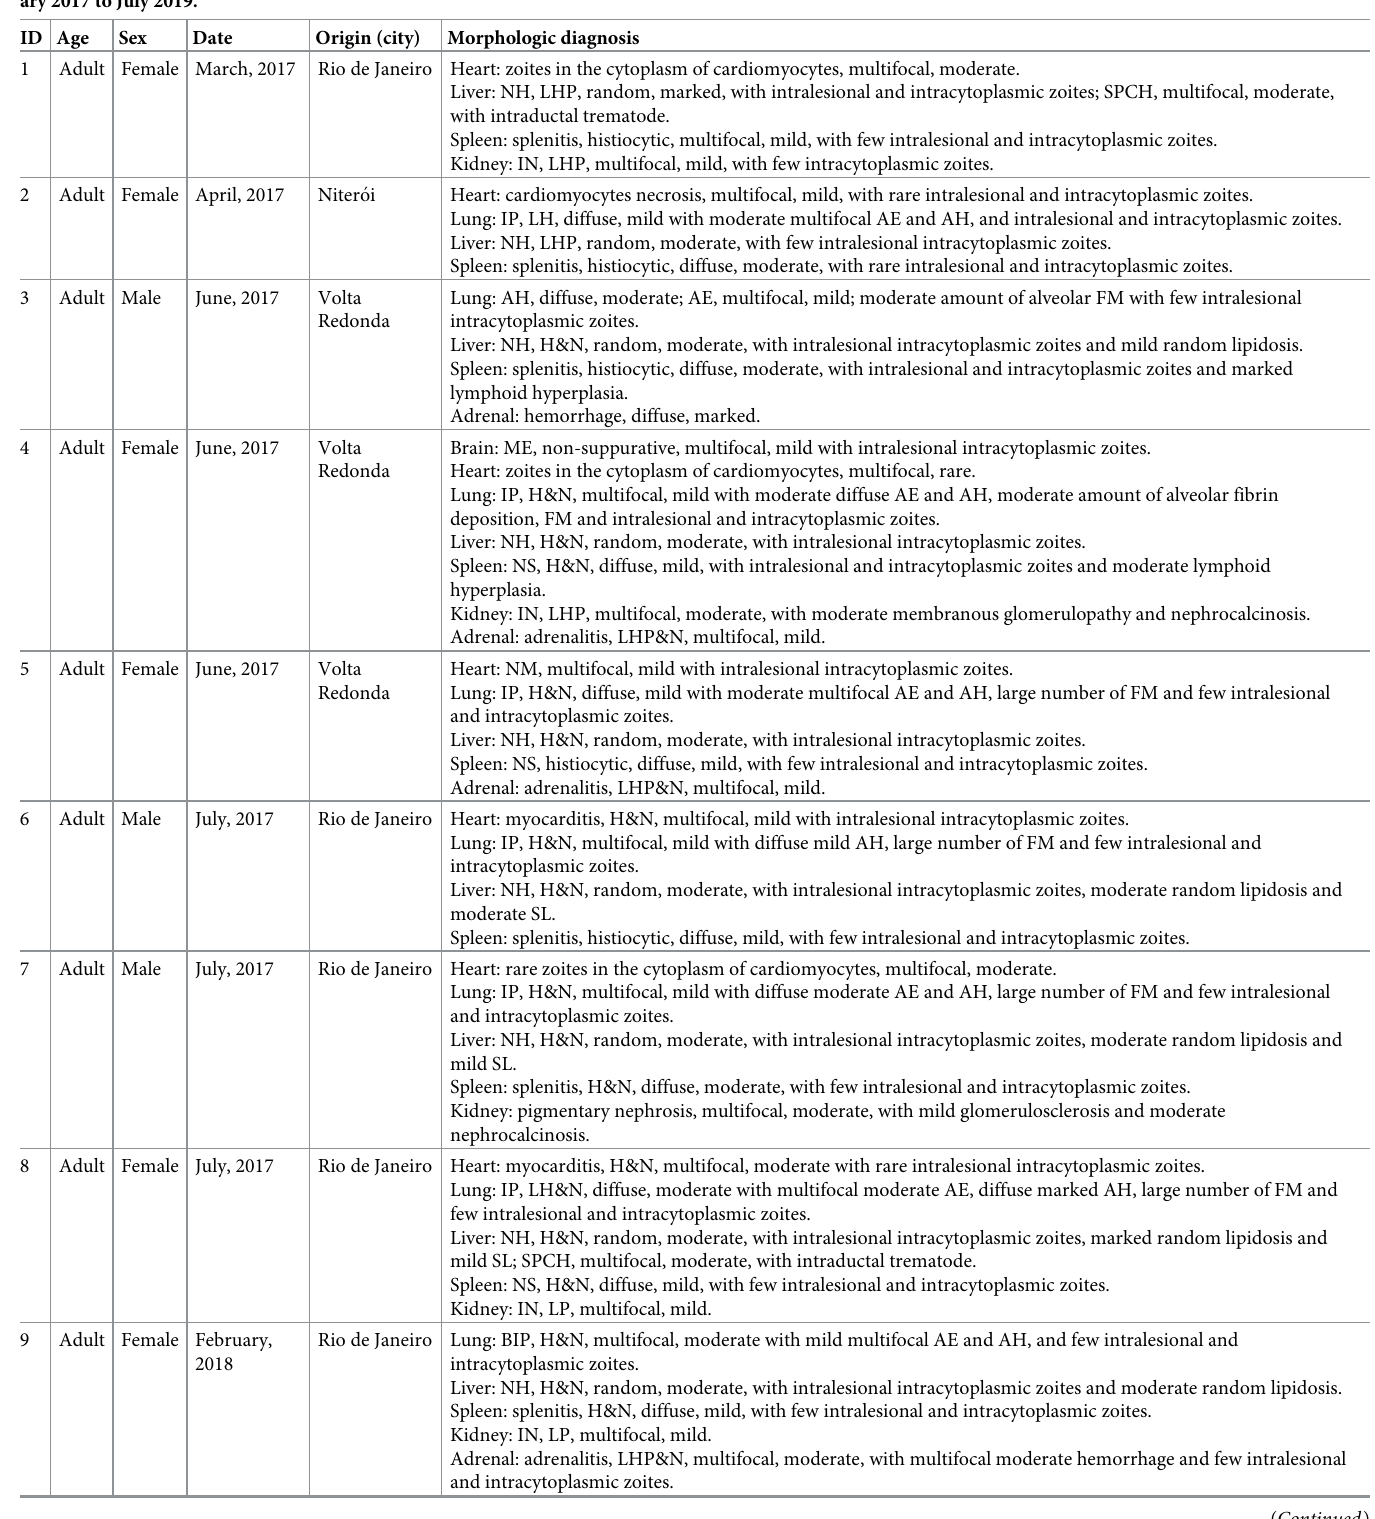
Table 1. General data and pathological findings of free-ranging marmosets ( Callithrix spp.) from the State of Rio de Janeiro (Brazil) with toxoplasmosis from Janu- ary 2017 to July